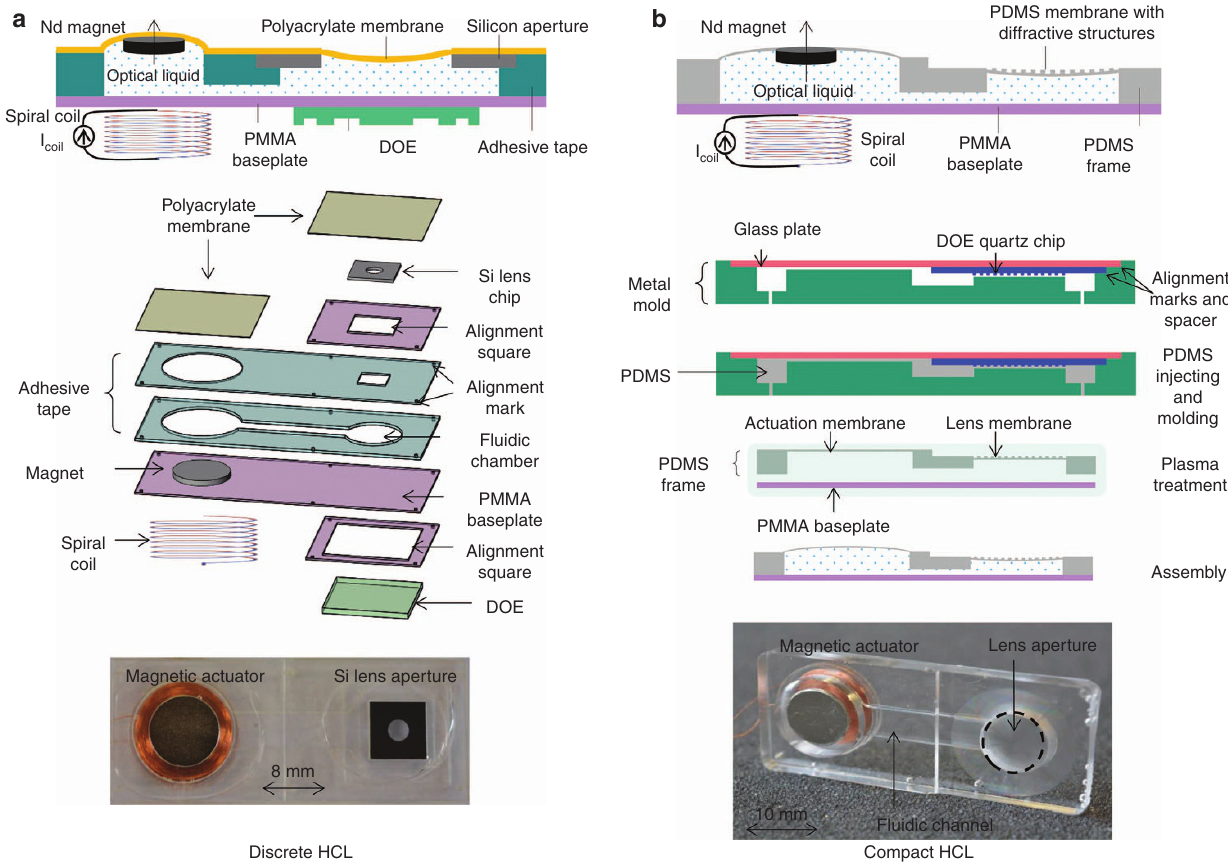
Figure 6 From top to bottom: schematic cross-sections; assembly processes; and photographs of the completed tunable hyperchromatic lenses with integrated magnetic actuators. From left to right: fabrication process for the discrete hyperchromatic lens ( a ) and fabrication process for the compact hyperchromatic lens ( b